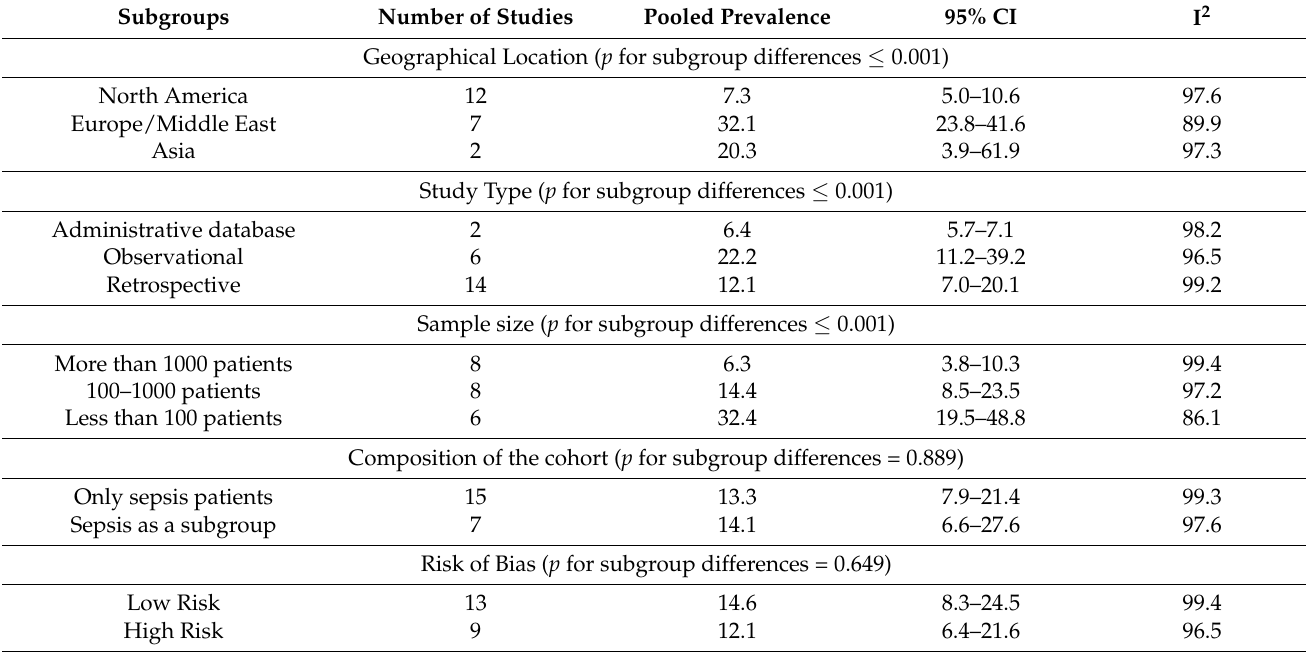
Table 2. Subgroup analysis of NOAF prevalence in patients with sepsis.